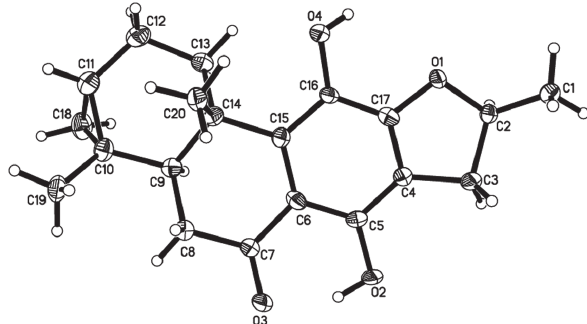
Table 1: Data collection and